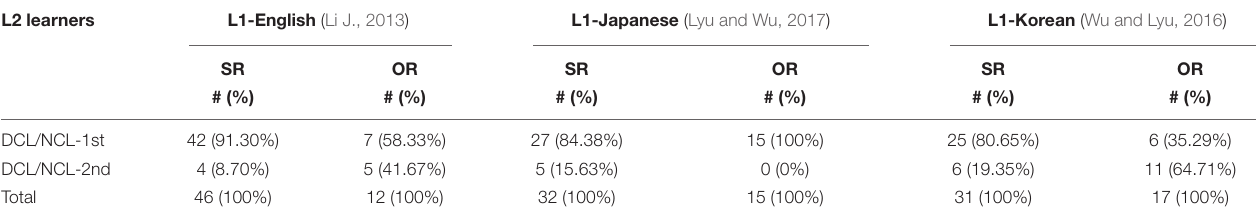
TABLE 2 | Distribution of NCL/DCLs in RCs found in the inter-language composition corpus reported in existing works on English-, Japanese-, and Korean-speaking L2-Chinese